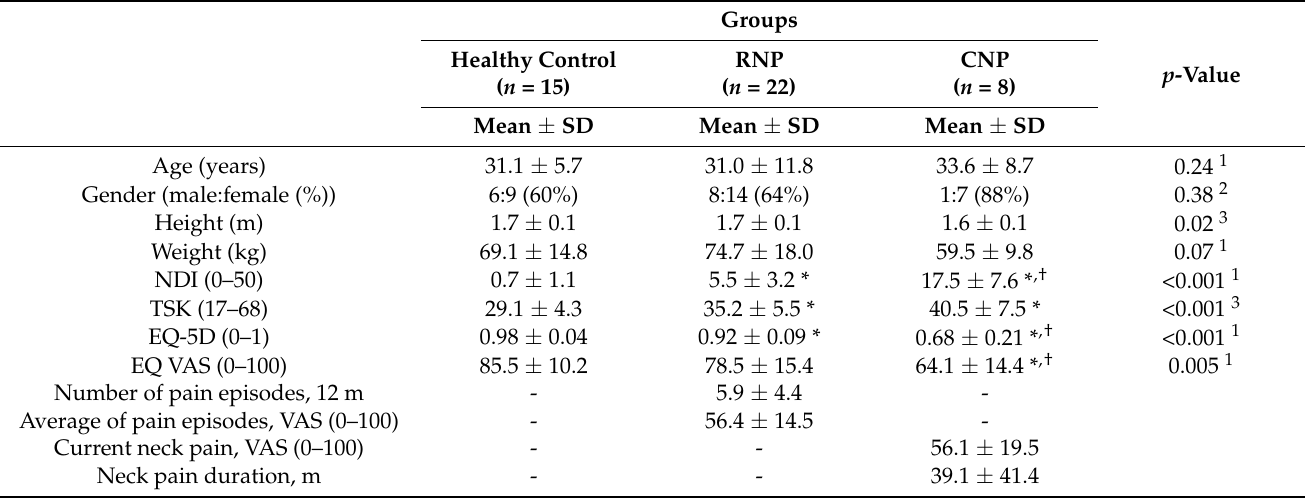
Table 2. Baseline characteristics of all three